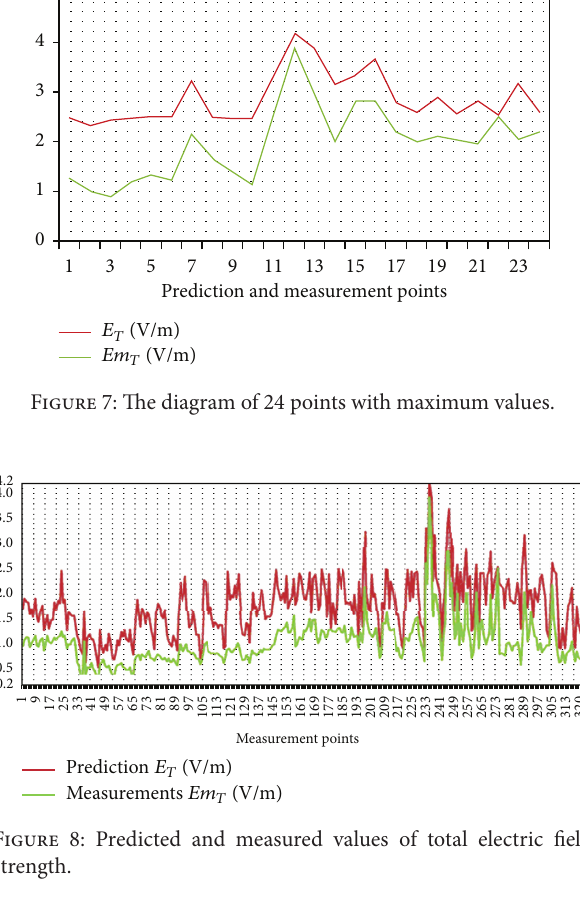
Table 4: Comparative overview of prediction and measurements results at 24 points with maximum values.